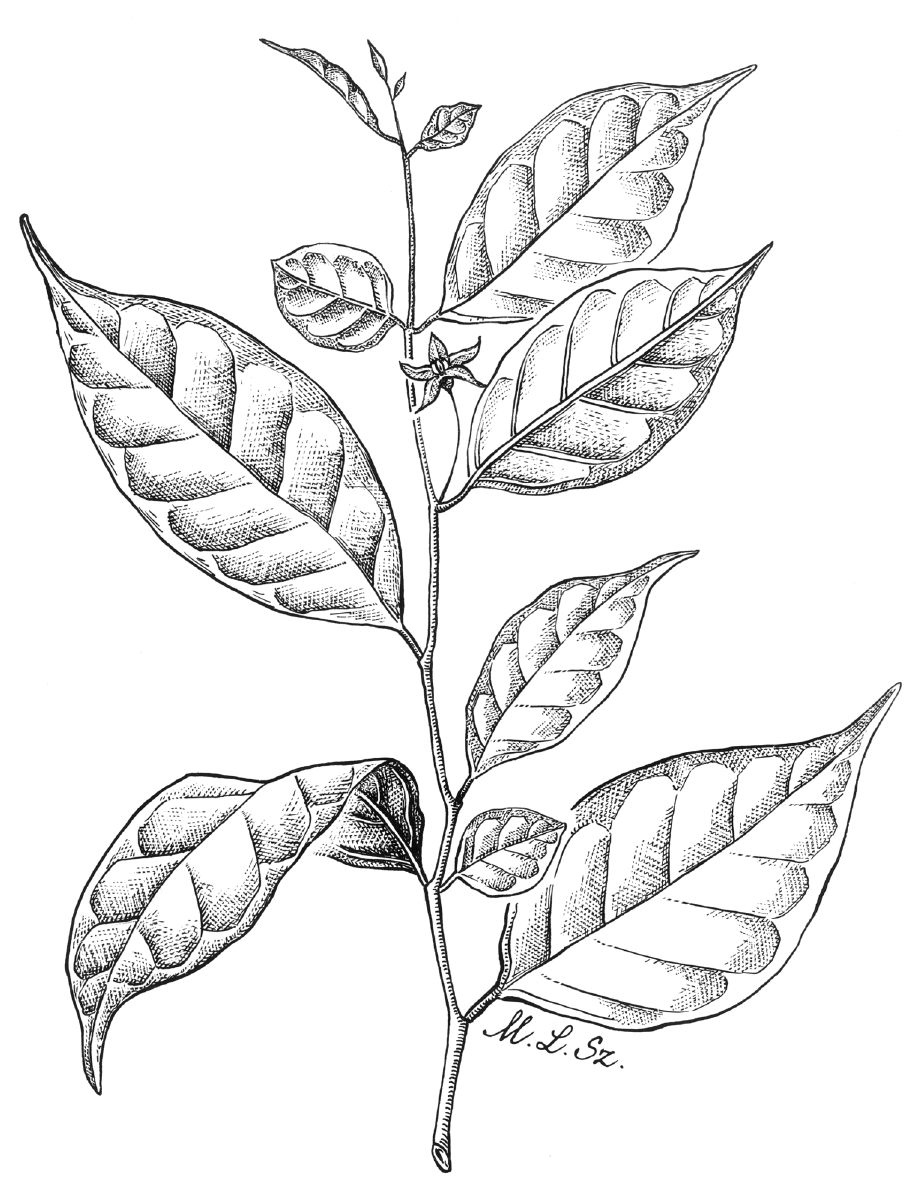
Figure 54. Lycianthes wollastonii (Wernham) A.R.Bean. Drawing by M.L. Szent-Ivany, first published in Symon (1985: fig. 25, as S. wollastonii Wernham). Courtesy of the Board of the Botanic Gardens and State Herbarium (Adelaide, South Australia), reproduced with